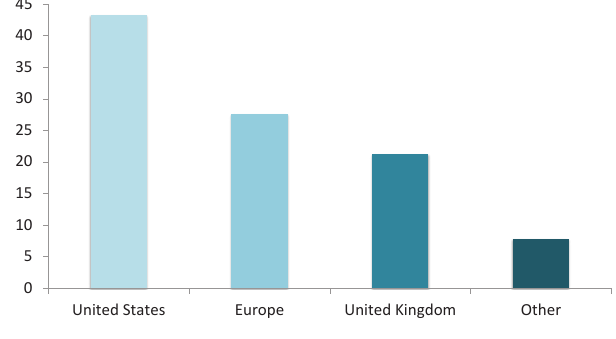
Figure 1. Participants’ Nationalities (%).